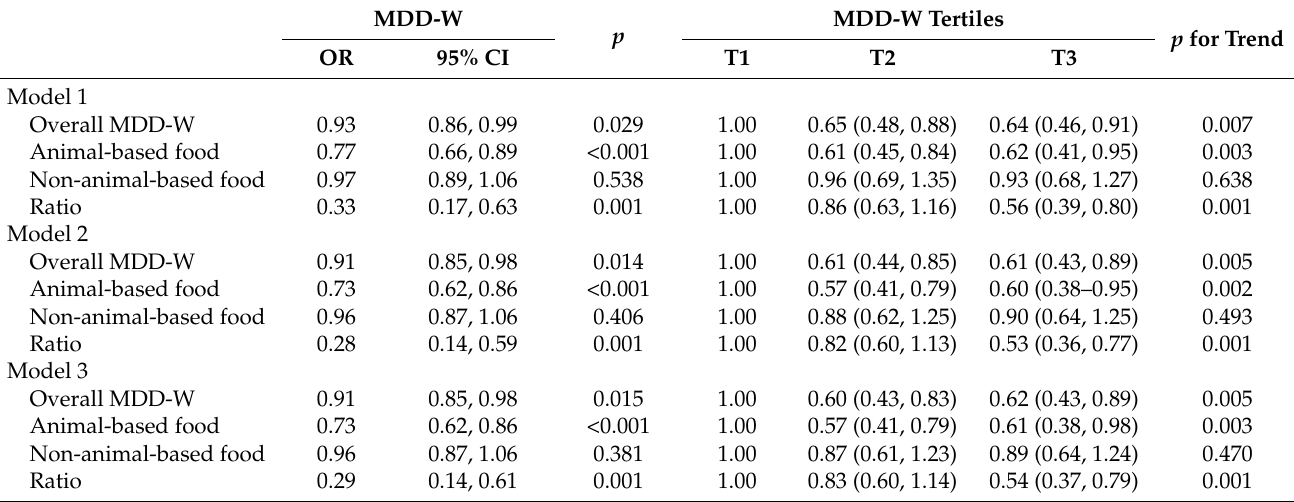
Table 3. Association between MDD-W and neonatal low birth weight by Logistic regression (OR (95% CI)) ( n =